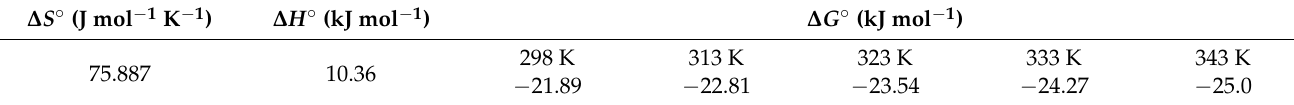
Figure 14. Plot of log K d vs. 1/ T of W(VI) ions adsorbed on HNAP/QA. Table 4. Thermodynamic parameters of W(VI) ions adsorbed on